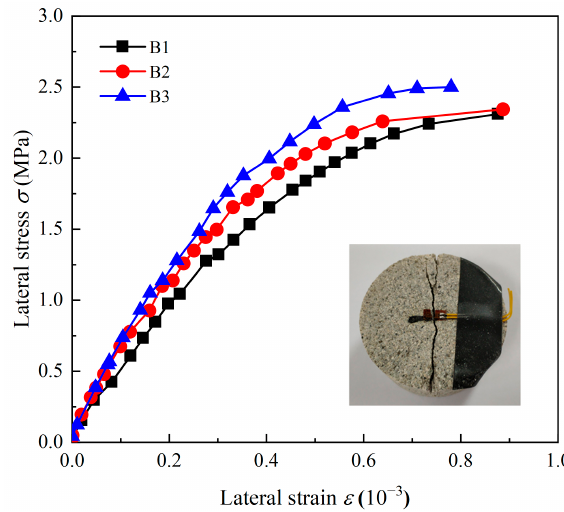
Figure 7. Indirect tensile stress–strain curves.